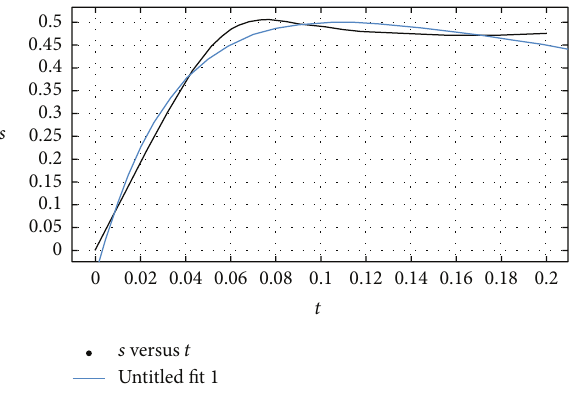
Figure 10: Curve fit with real roots.